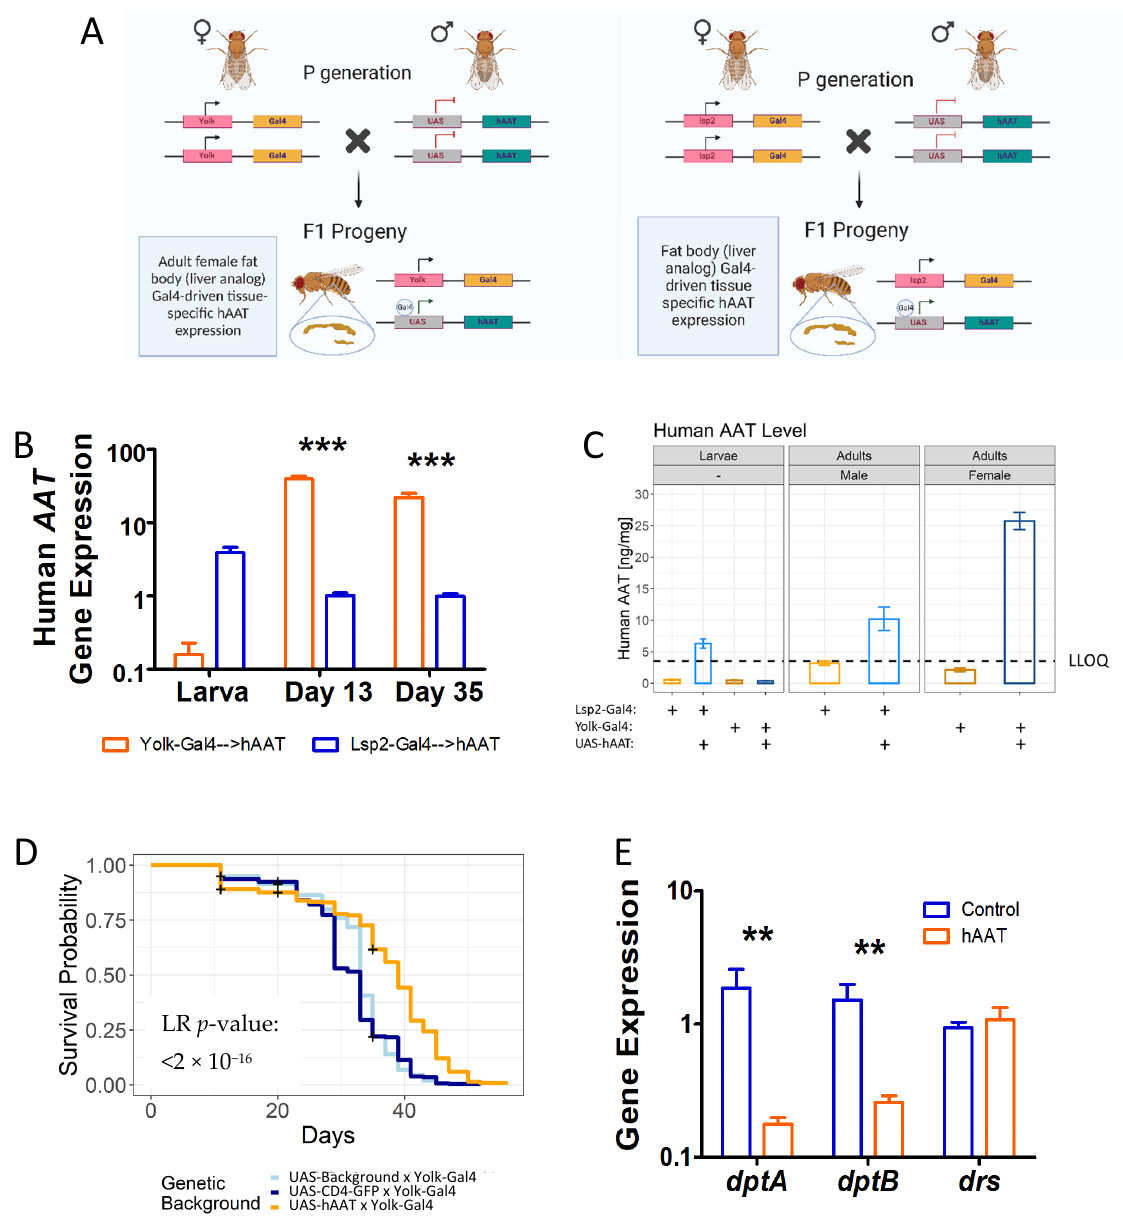
Figure 5. The anti-inflammaging effect of hAAT when only expressed in adult Drosophila . ( A ) Schematic of the Drosophila melanogaster adult fat body Yolk-Gal4-driven hAAT expression system. ( B ) Whole-body Yolk-Gal4-driven hAAT mRNA transcription across the fly lifespan obtained using qRT-PCR (N = 5–6). Relative expression was calculated using the pflaffl method [43] with Rpl32 as a reference gene; a two-way ANOVA test was used for statistical analysis (*** p < 0.001). ( C ) Yolk-Gal4-driven hAAT secretion detected using a hAAT-specific ELISA across the fly lifespan. A mixture of stage 2 and stage 3 larva was used. Bar represents the mean hAAT amount per fly. Error bar represents the standard error. Dotted line represents lower limit of quantitation (LLOQ). ( D ) Effect of Yolk-Gal4-driven hAAT expression on lifespan in female Drosophila melanogaster (N = 382, 345, and 412 at the beginning of the experiment for Background (docking strain) x Yolk-Gal4, UAS-CD4-GFP x Yolk-Gal4, and UAS-hAAT x Yolk-Gal4, respectively). A log-rank test was used for statistical inferences. The plus sign represents data censoring. ( E ) Effect of Yolk-Gal4-driven hAAT expression of Diptericin A ( dptA )and B ( dptB ) in female adult Drosophila melanogaster aged to 35 days. Relative expression was calculated using the Pflaffl method [43] with Rpl32 as a reference gene; a Mann-Whitney test was used for statistical analysis. ** p < 0.01. Error bar represents standard error of the